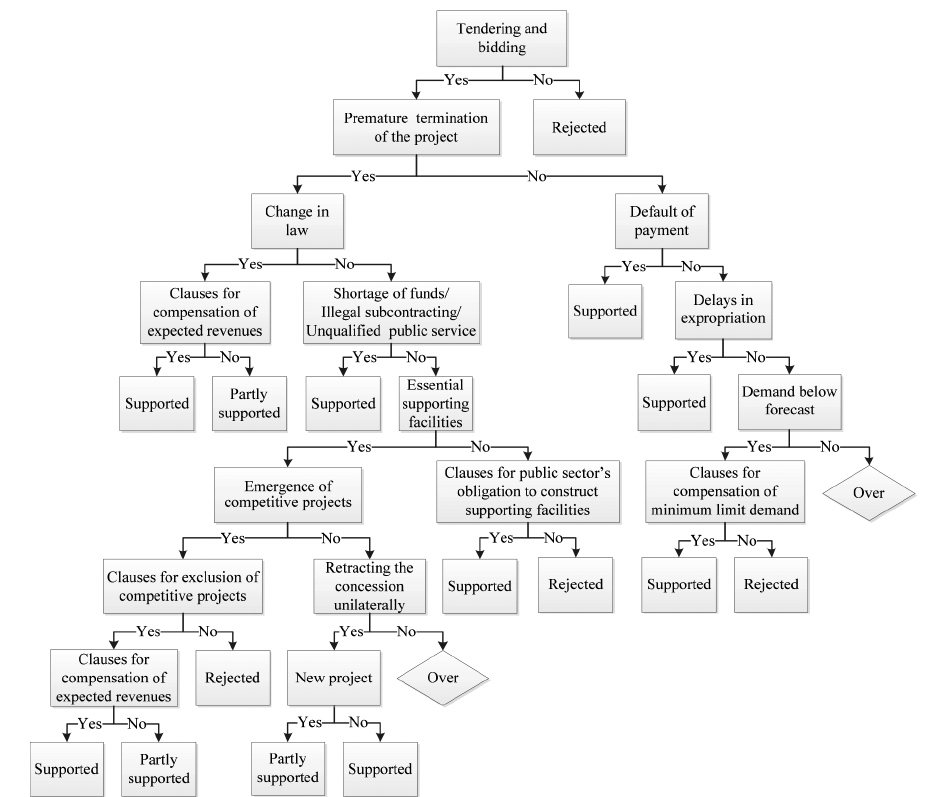
Figure 3. From legal factors to the litigation